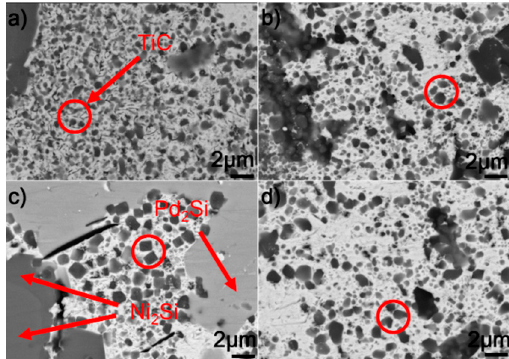
Figure 10. BSE images indicating the braze seams obtained at 1523 K for different soaking times: ( a ) 10 min; ( b ) 30 min; ( c ) 60 min; ( d ) 90 min.